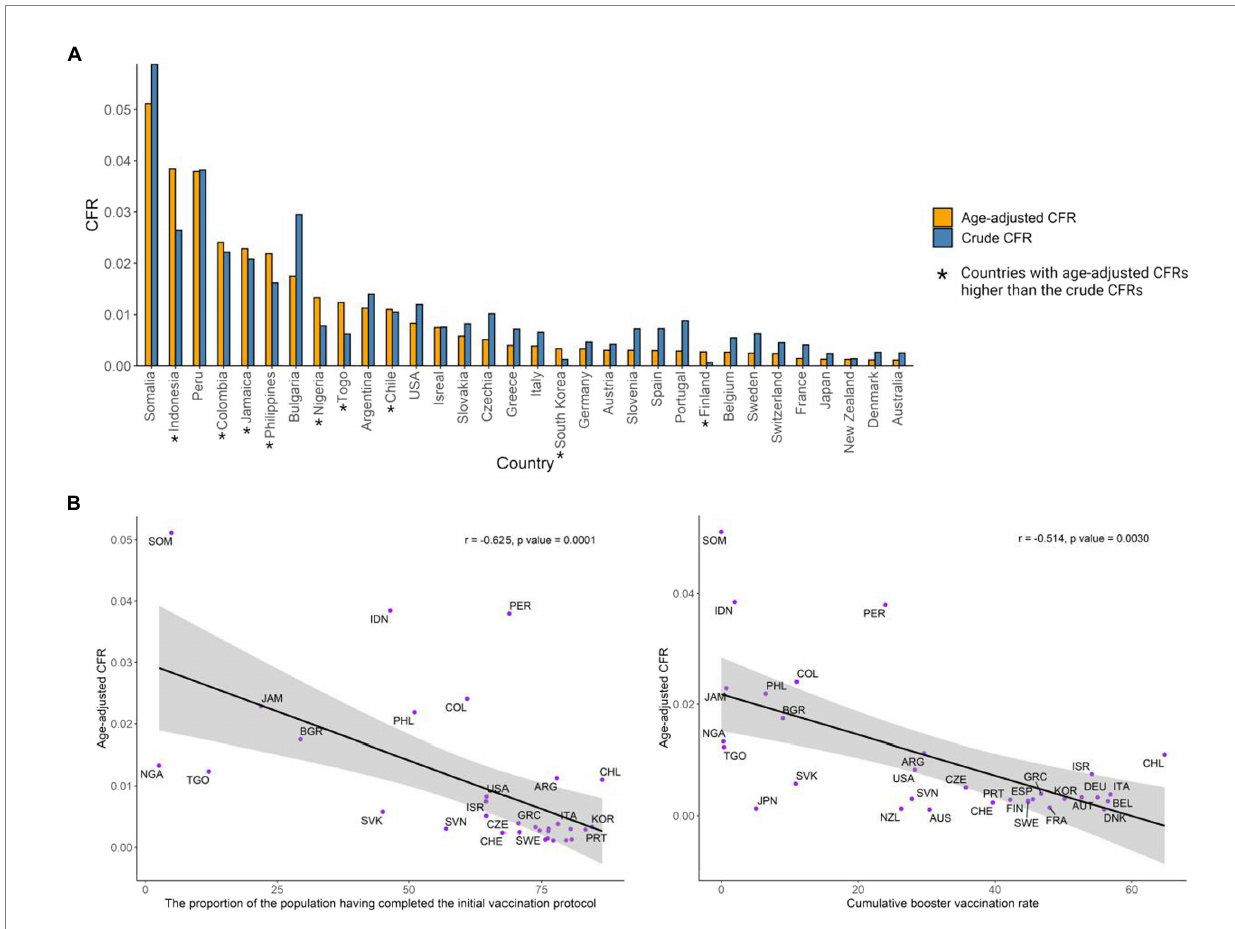
FIGURE 2 (A) Crude CFRs and age adjusted CFRs in the 32 countries. (B) The correlation between age-adjusted CFRs and vaccination coverage (fully vaccinated and booster